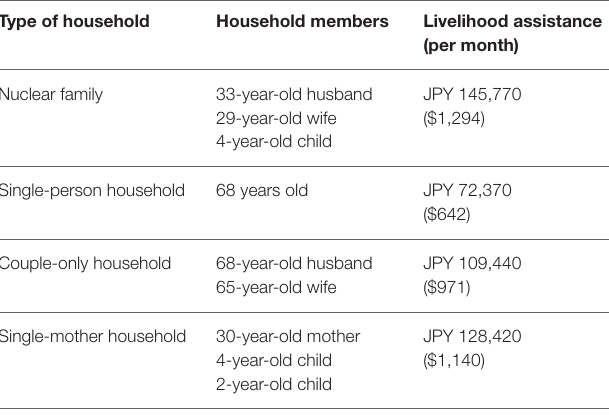
TABLE 3 | Amounts of livelihood assistance